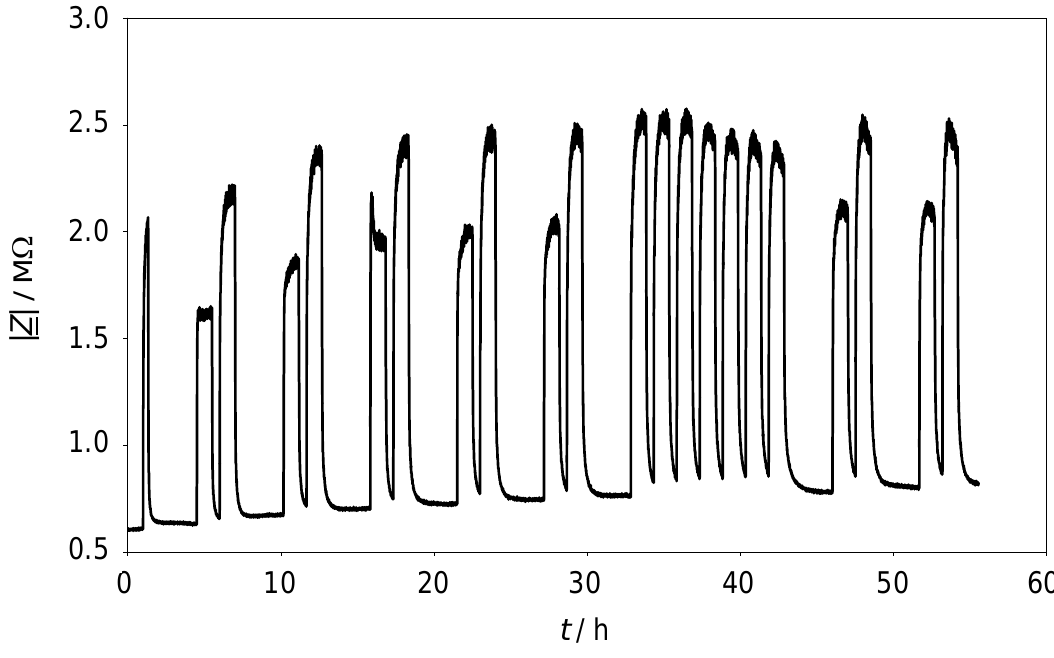
Figure 7. Long-term measurement of | Z | at 3 Hz and 330 °C. Pulses (duration 1 h, with the exception of the first one (20 min)) of 250 ppm and 500 ppm C gas of 10 % O and 2.5 % H O in N 2 2